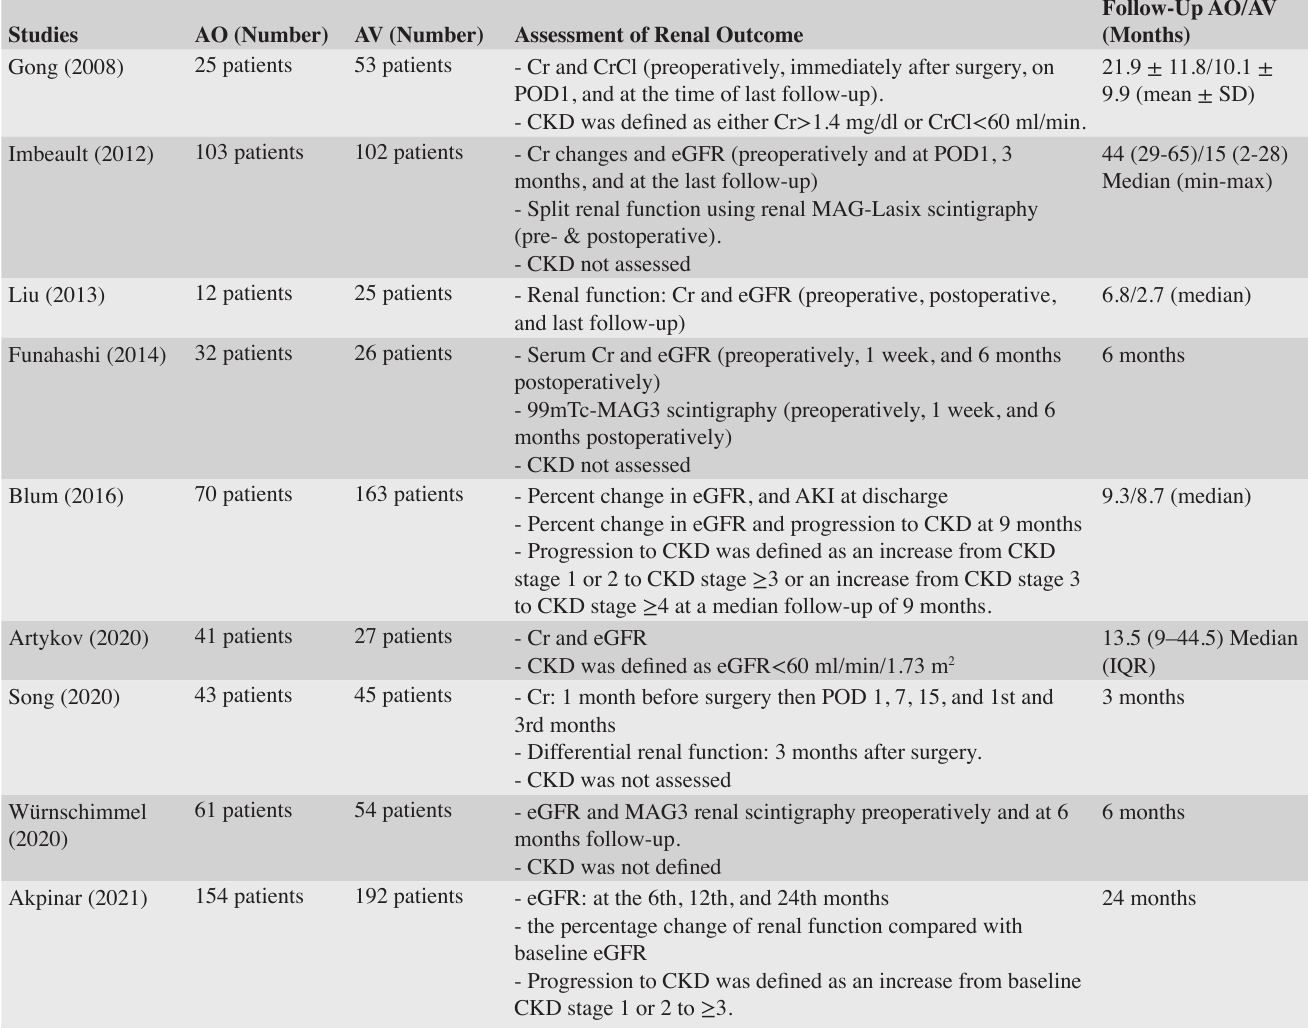
Table 2. The sample size, assessment of renal outcome, and follow-up of patients in the included studies (n = 9)